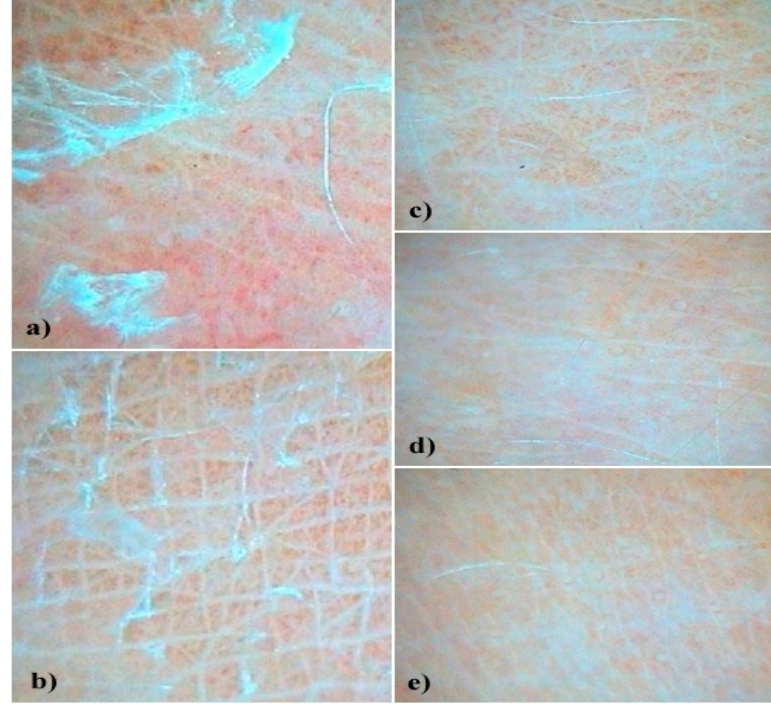
Figure 7. Photographs of the skin of assessor 3 with sunburns: ( a ) skin burn before the preparations were used. Skin burn after 7 days: ( b ) control group; ( c ) preparation G; ( d ) preparation M; ( e ) nanoemulsion NG-Carb-1.0.